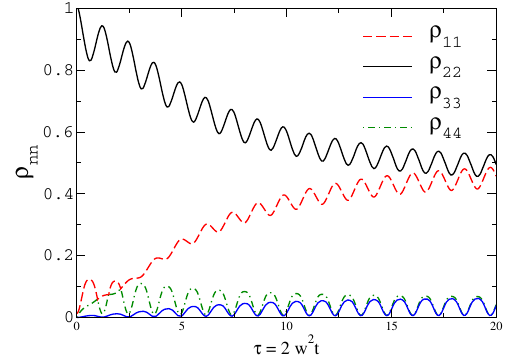
Fig. 9 The time dependence of eigenvalues ρ nn of the density matrix ˆ (cid:13) when β = π/ 6, ¯ ω = μ ν B /w 2 = 10 and μ ν B /ω ν = 5 B Here ˆ (cid:13) d ( t ) is the diagonal part of ˆ (cid:13)( t ) in the flavor basis (3), i.e., ˆ (cid:13) d = diag (ρ d 11 , ρ d 22 , ρ d 33 , ρ d 44 ) . Further,